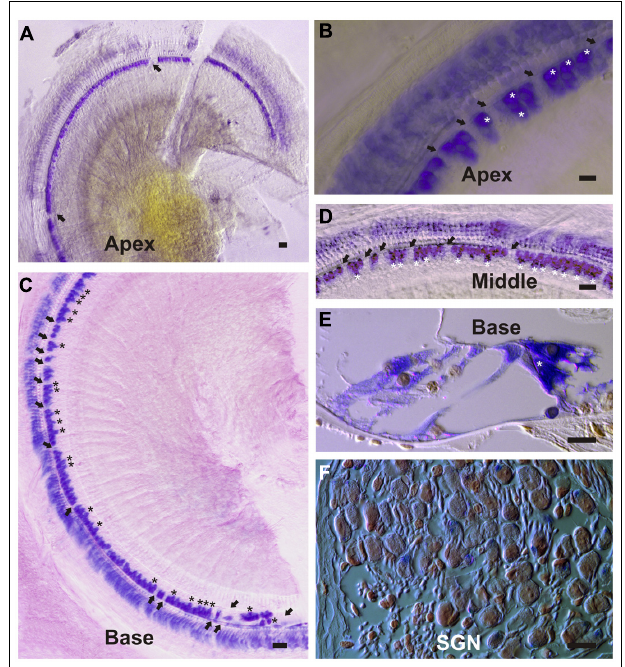
FIGURE 10 | DN-CBRb transgene expression in a P21 DN-CBRb + / ROSA-CAG-rtTA + mouse cochlea. (A–F) Strong cytoplasmic and nuclear ISH signal was observed at the inner hair cells (IHCs), region of Dox-treated DN-CBRb + / ROSA-CAG-rtTA + mouse cochlea. (A–D) Transgene expression was detected throughout the length of the cochlea, but visibly stronger at the middle and basal regions compared to the apex of the cochlea. Mosaic DN-CBRb expression was observed (arrows) and may indicate incomplete recombination in those cells. Likewise, supernumerary cells (asterisk) showed strong hybridization signal, suggesting efficient transgene transmission to the newly formed cells. (E) Sections of the cochlea counterstained with Nuclear Fast Red, confirmed our observations on whole mount preparations and allowed for a better appreciation of a supernumerary IHC (asterisk), as well as some light transgene expression in the spiral ganglion neurons (F) . SGN , spiral ganglion neurons; Bar = 10 μ